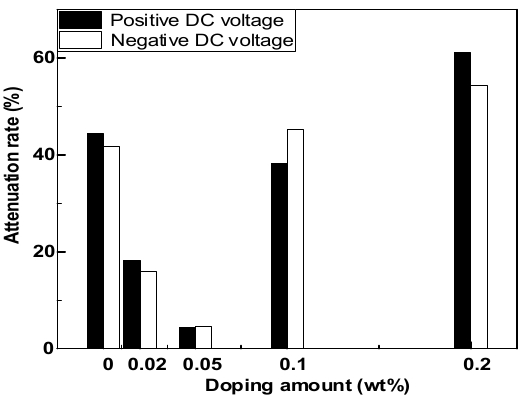
Figure 9. SPD characteristics of epoxy resin-GO composites.